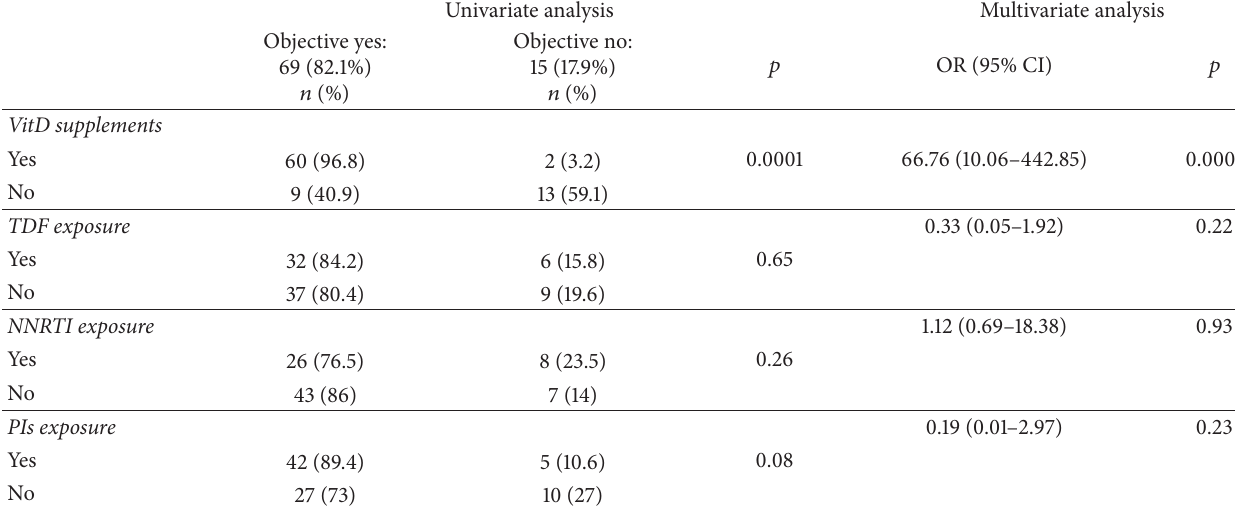
Table 2: Patients with vitamin D < 10ng/mL at baseline. Objective vitamin D > 20ng/mL. Univariate and multivariate analysis. Univariate analysis Multivariate analysis